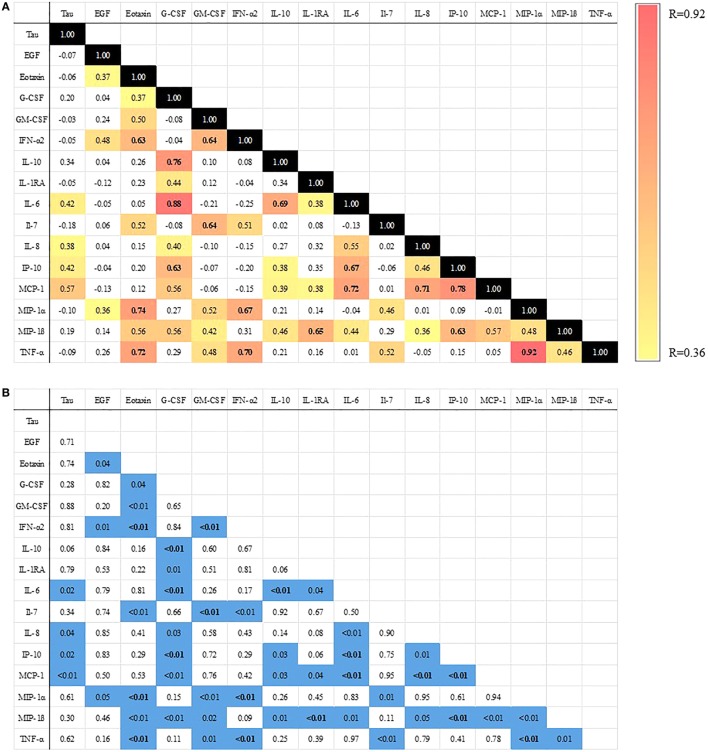
Heat map of Spearman correlations between change in cerebrospinal fluid (CSF) cytokine levels from 0 to 24 h after surgery. (A) All colored cells are significant at p < 0.05. Bolded cells are significant after Bonferroni correction (25). Color bar ranges from yellow (R = 0.36 or smallest significant spearman correlation) to red (R = 0.92 or largest significant spearman correlation). (B)
p Values for each comparison in part A [values <0.05 highlighted in blue and values significant after Bonferroni correction are bolded (25)].